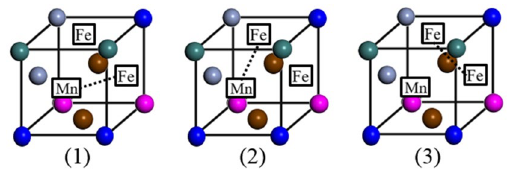
Figure 5. Schematic diagram of the 3A tri-vacancy cluster with different atomic vacancy formation sequences. The two elements enclosed within squares and connected by dotted lines in the figures each indicate the configuration of the di-vacancy cluster formed first, and the other element (also enclosed within a square) represents the third vacancy of the tri-vacancy cluster.